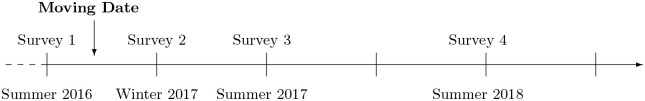
Timing of survey waves.The figure illustrates the exact timing of each survey wave. The first survey (k = 0) took place before the moving date (August 2016). The second (k = 1), third (k = 2) and fourth (k = 3) took place after the relocated group moved to the new building, in respectively January 2017, July 2017 and October 2018.